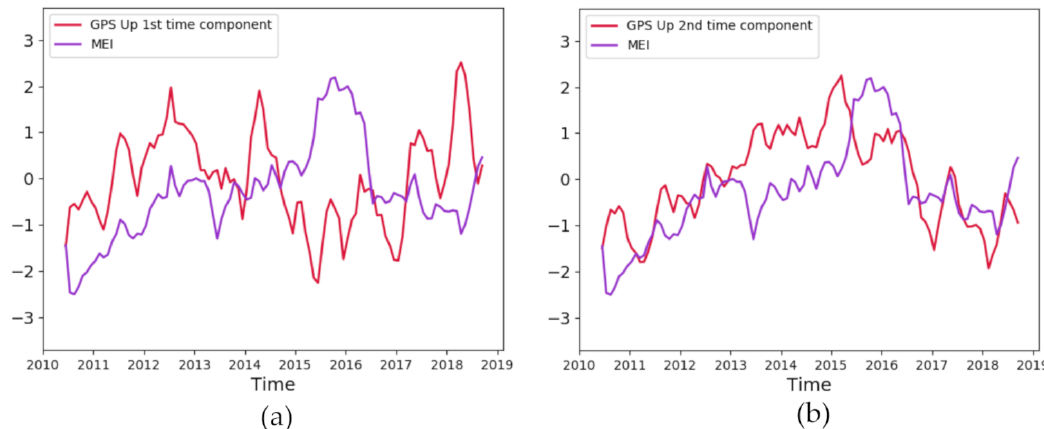
Figure 17. Standardized monthly time series of the MEI (purple line) and of the first ( a ) and second ( b ) PCA time components of the Up coordinate.